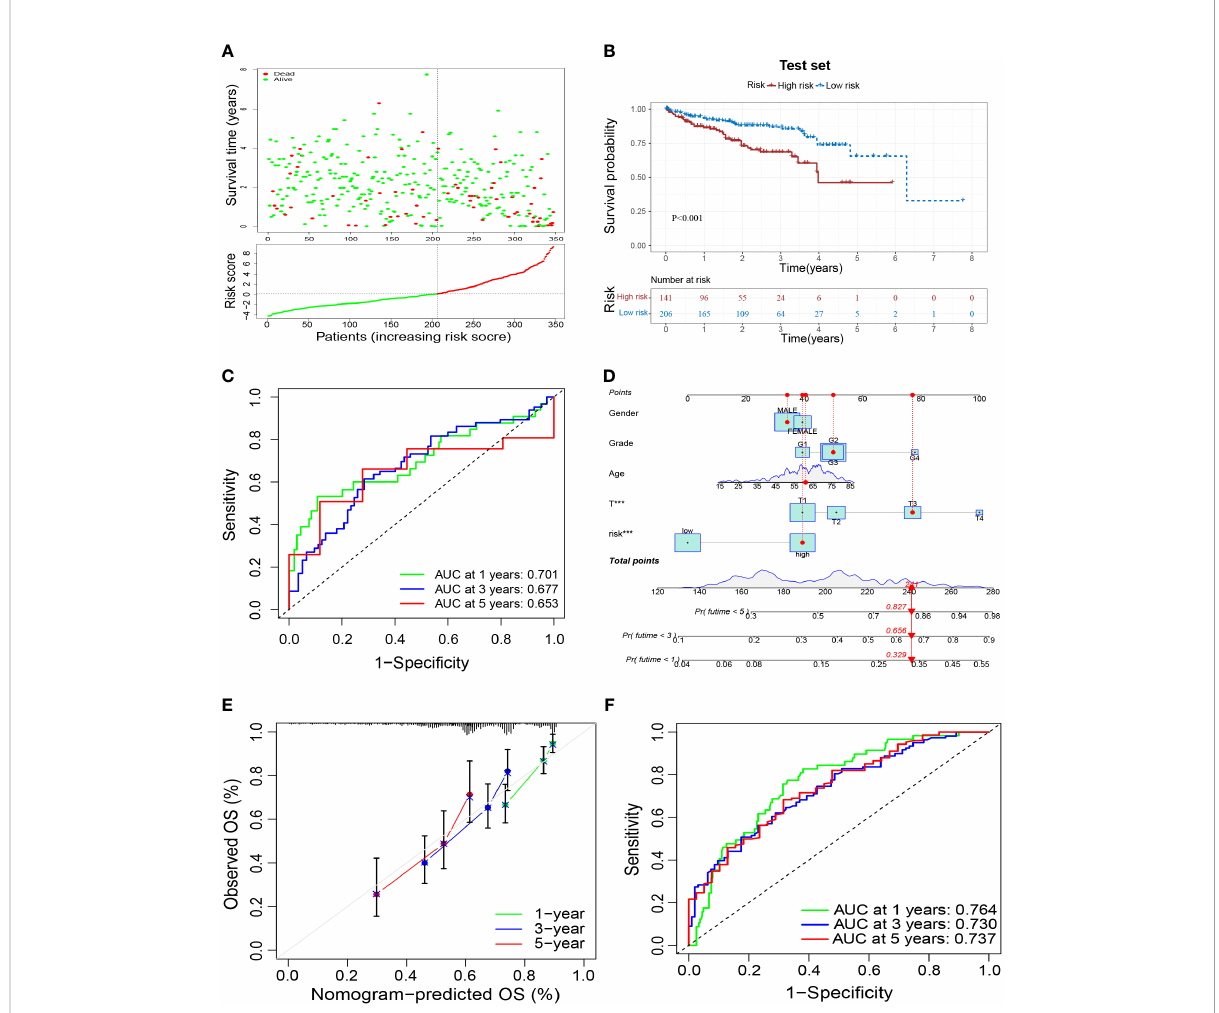
FIGURE 6 External validation of a M2-like TAM-related prognostic signature. (A) Survival status and risk scores of HCC patients in the high- and low-risk groups in the test set. Green dots denote low risk and red dots denote high risk. (B) Kaplan – Meier survival curves showed a signi fi cantly worse prognosis for the high-risk group in the test set. (C) ROC curves for 1, 3, and 5 years and their AUCs. (D) Nomogram based on risk scores and clinical indicators. The results of a calibration curve (E) and ROC curves (F) showed the reliable performance of the nomogram. TAM, tumor- associated macrophage; HCC, hepatocellular carcinoma; ROC, receiver operator characteristic; AUC, area under curve.